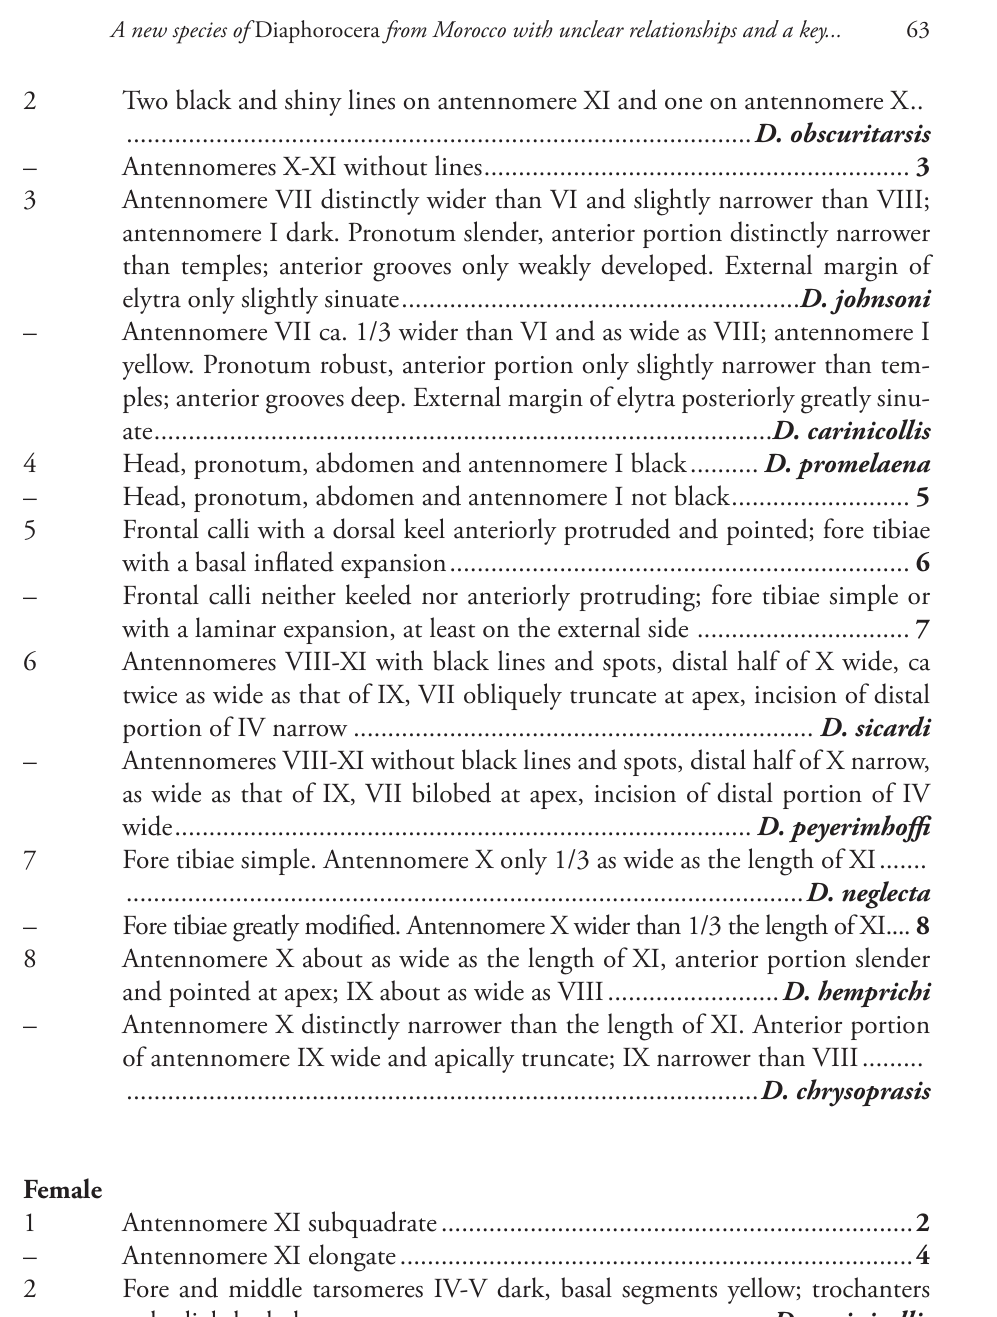
Fore and middle tarsomeres IV-V dark, basal segments yellow; trochanters – Tarsomeres and trochanters dark, or fore tarsomere I light at base ............... 3 3 Labrum completely dark; temples slightly diverging posteriad, maximum width of head on temples. Femurs and tibiae orange-red .... D. obscuritarsis – Labrum dark with the anterior margin orange; temples parallel, maximum width of head on eyes. Femurs and tibiae yellow ........................ D.